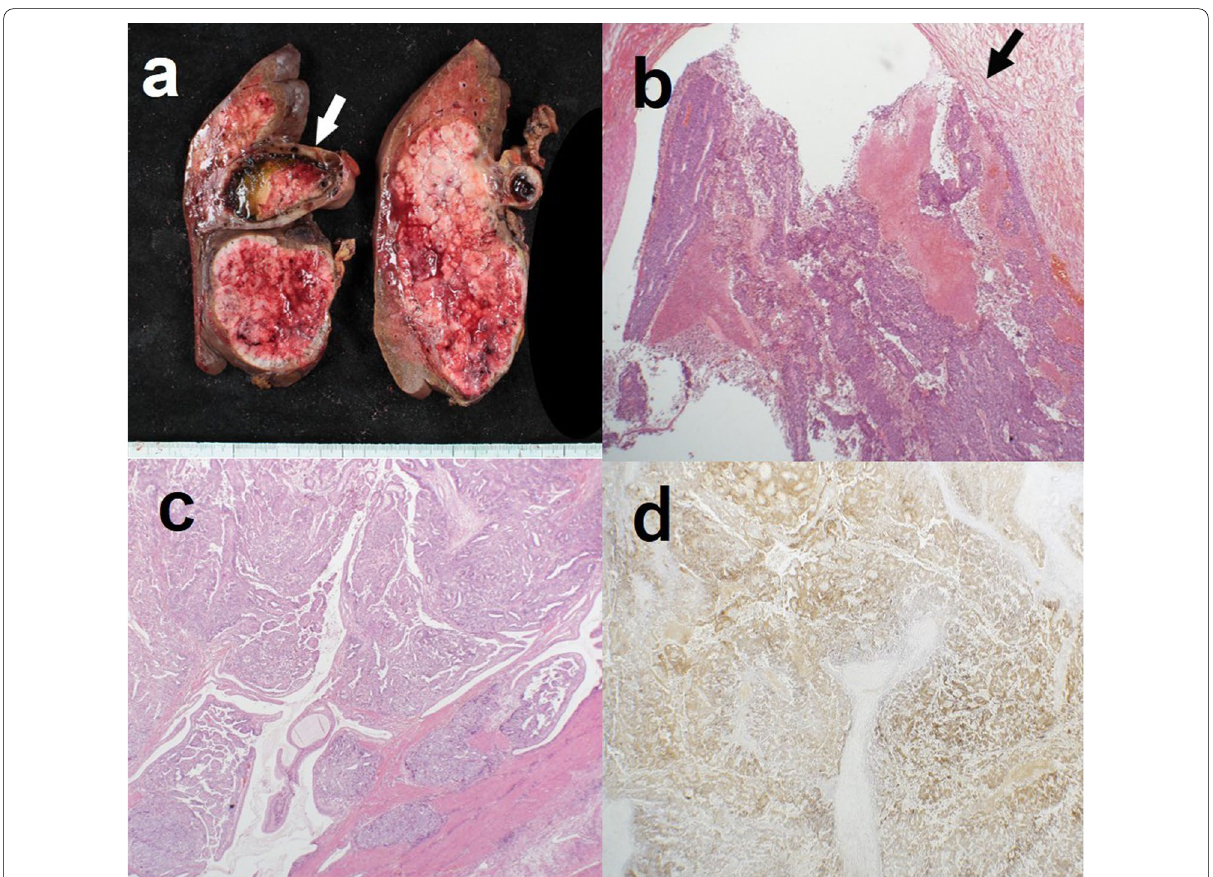
Fig. 4 a Cut surface of the resected specimens shows multinodular fused lesions in the liver and a papillary tumor in the gallbladder with